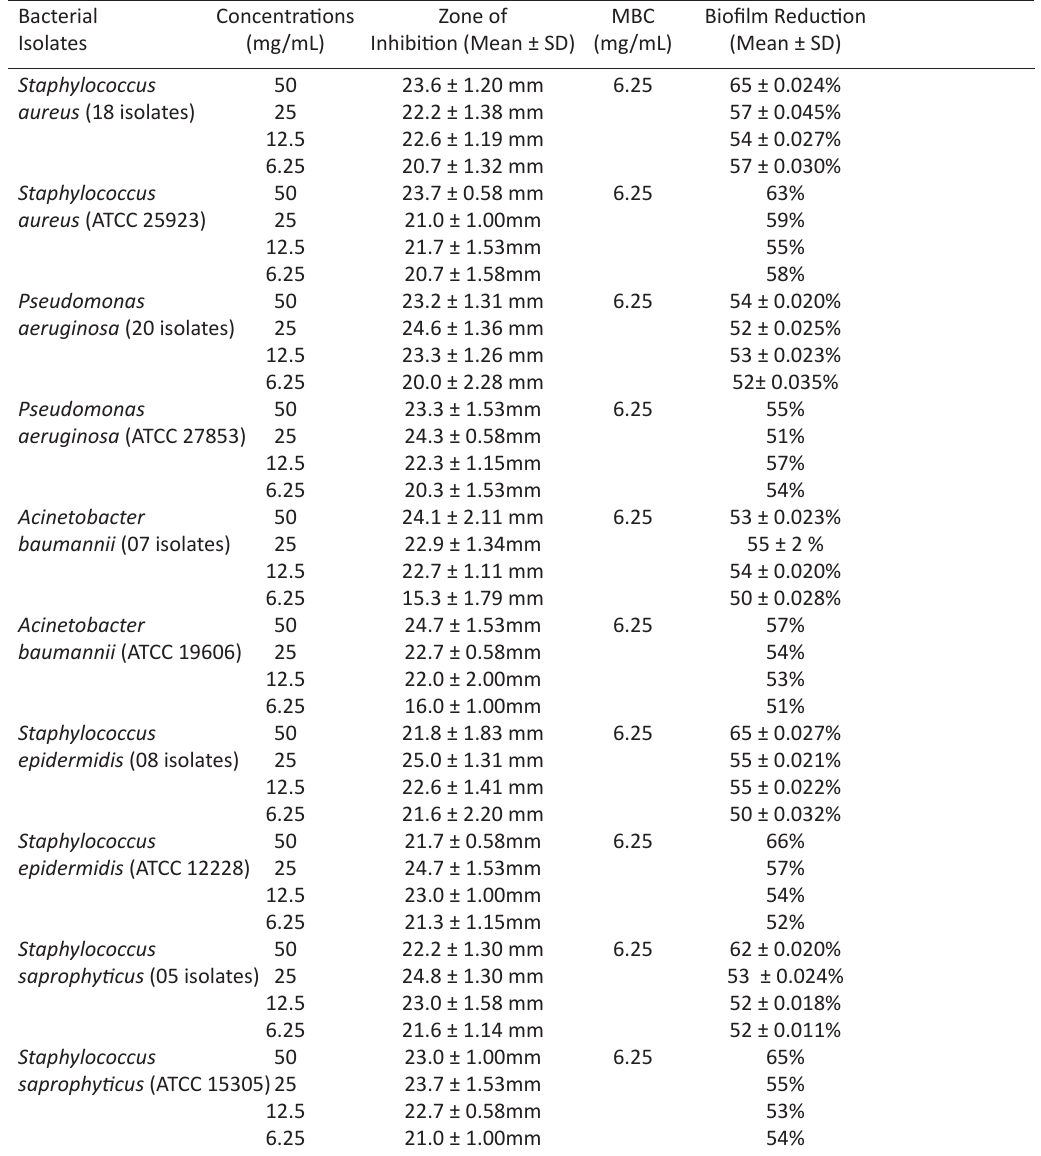
Table 2. Antibacterial and antibiofilm activity of Syzygium aromaticum Bacterial Concentrations